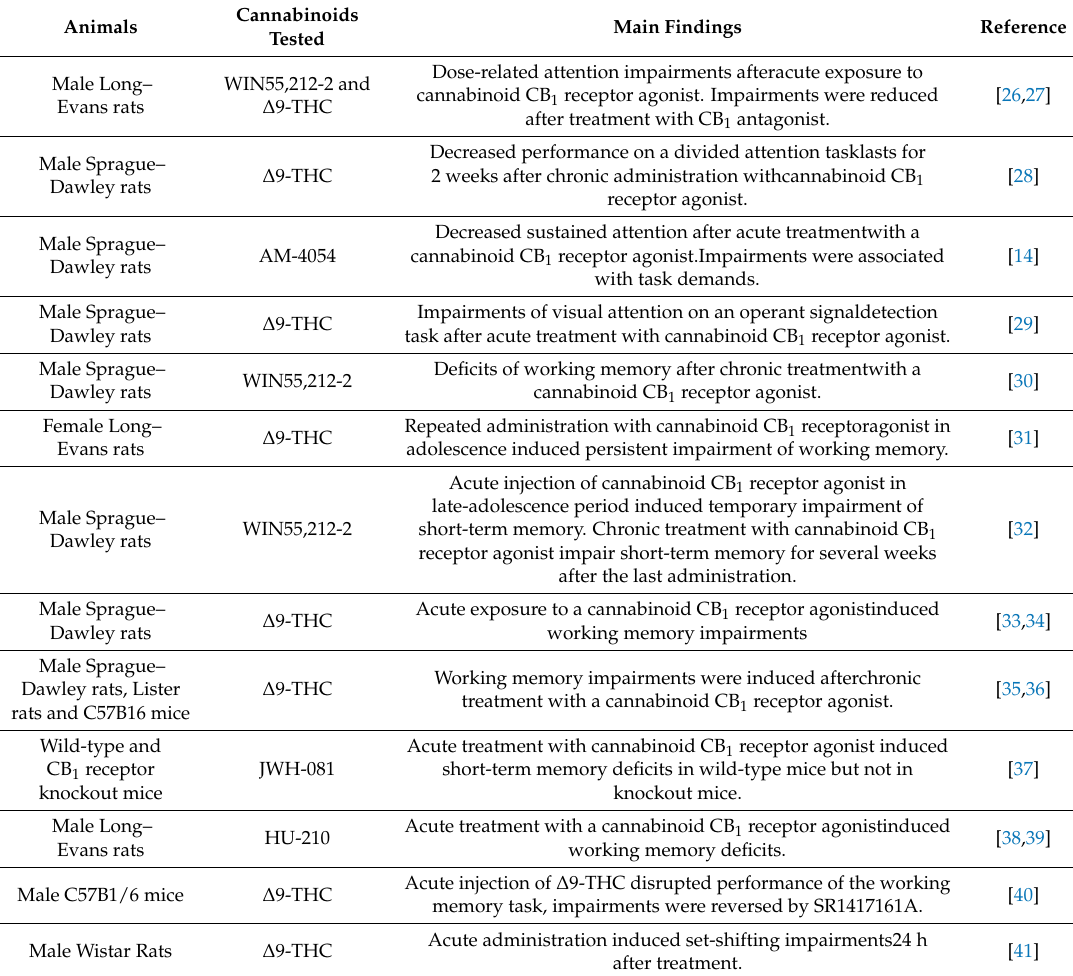
Table 2. Pre-clinical rodent studies of the effects of cannabinoid-agonists on executive function.